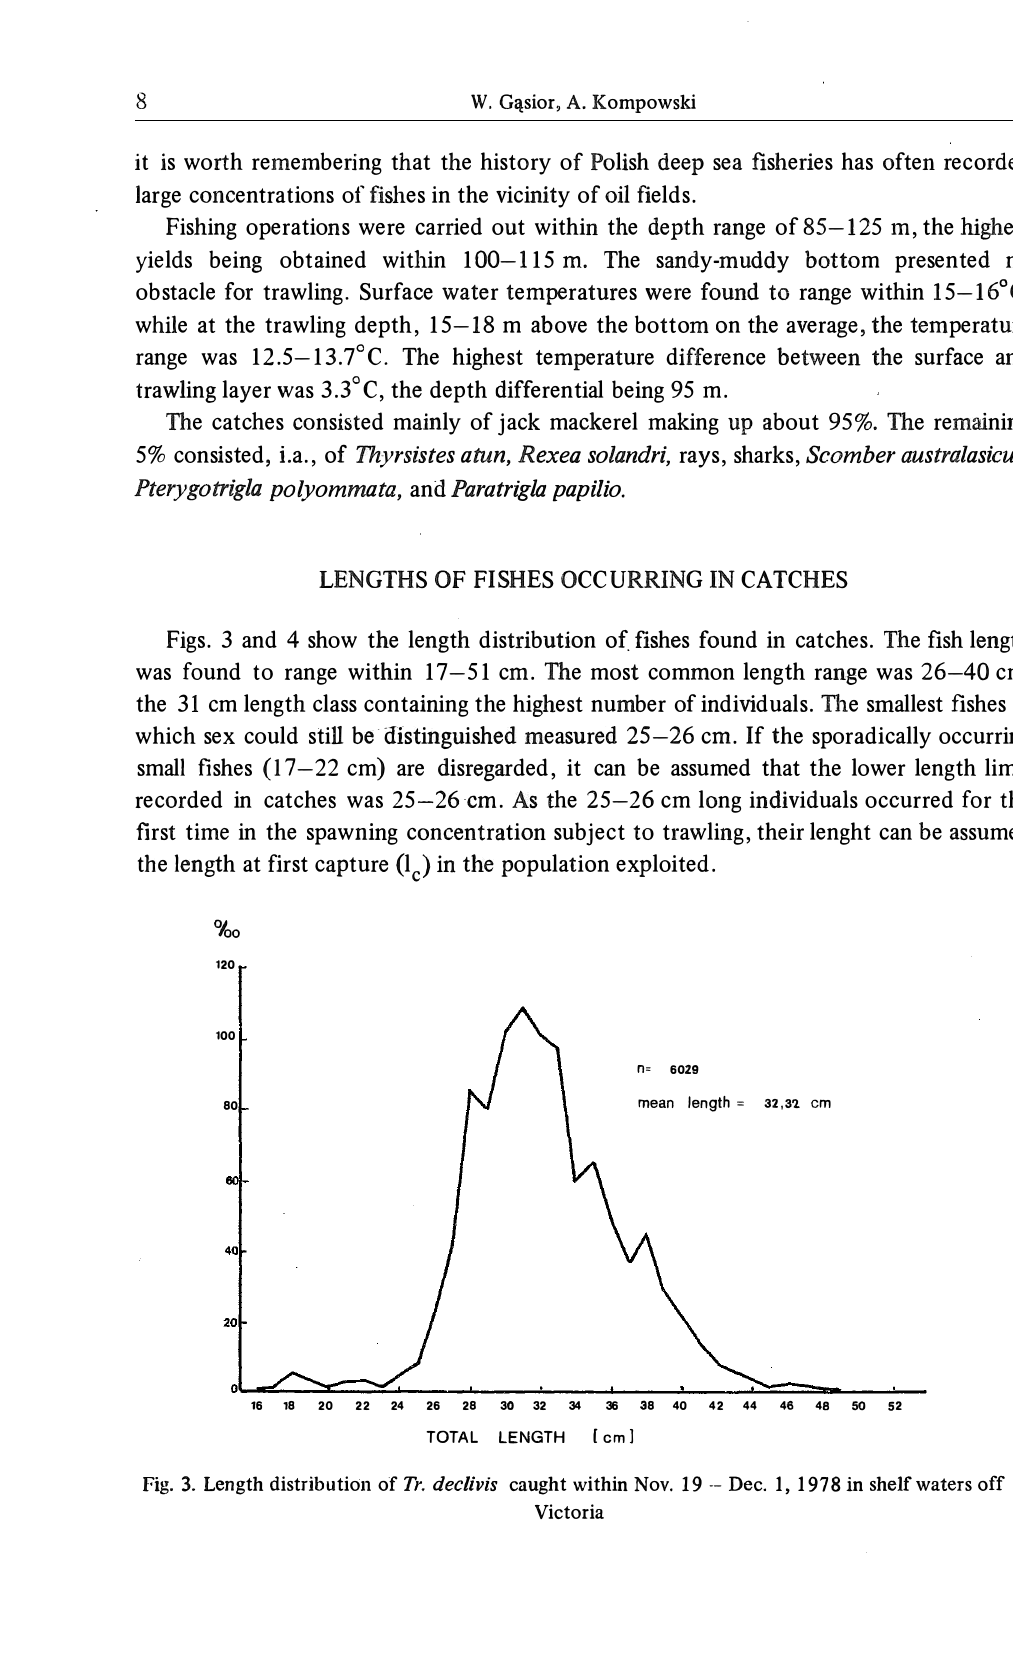
Fig. 3. Length distribution of Tr. declivis caught within Nov. 19 ·- Dec. 1, 197 8 in shelf waters